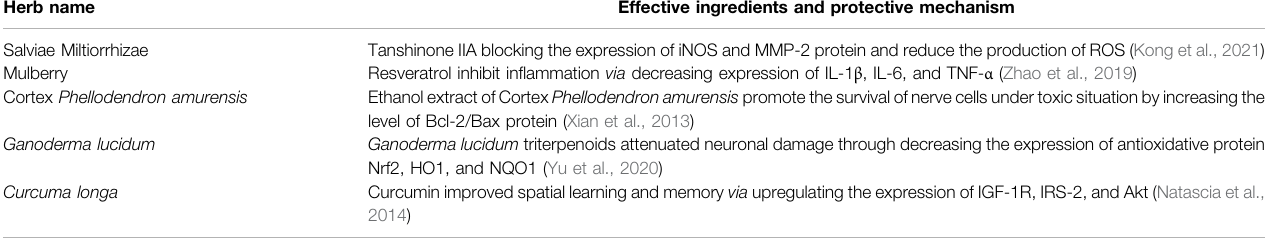
TABLE 1 | Herbal medicine exerts protective effect on dementia. Herb name Effective ingredients and protective mechanism Salviae Miltiorrhizae